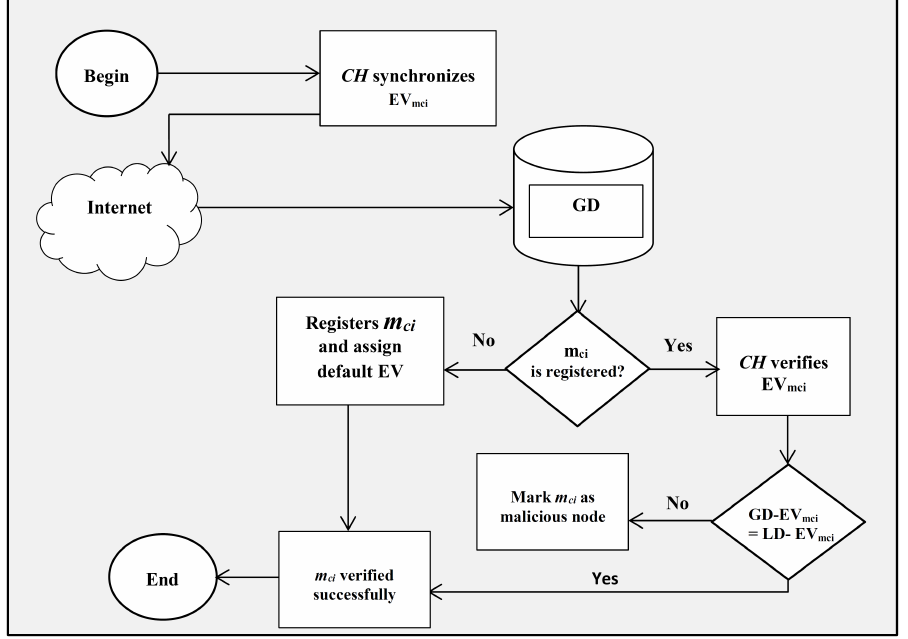
Figure 6. Procedural flowchart for energy valuation